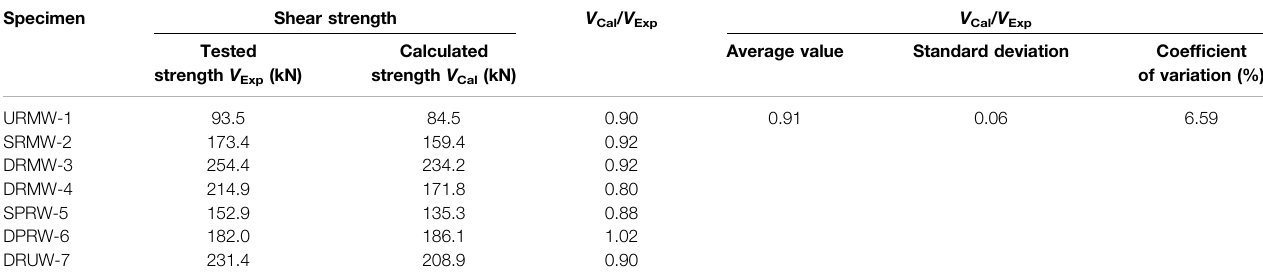
TABLE 7 | Comparison of shear strength between calculated and tested values. Specimen Shear strength V Cal / V Exp V Cal / V Exp Tested Calculated Average value Standard strength V Exp (kN) strength V Cal (kN)